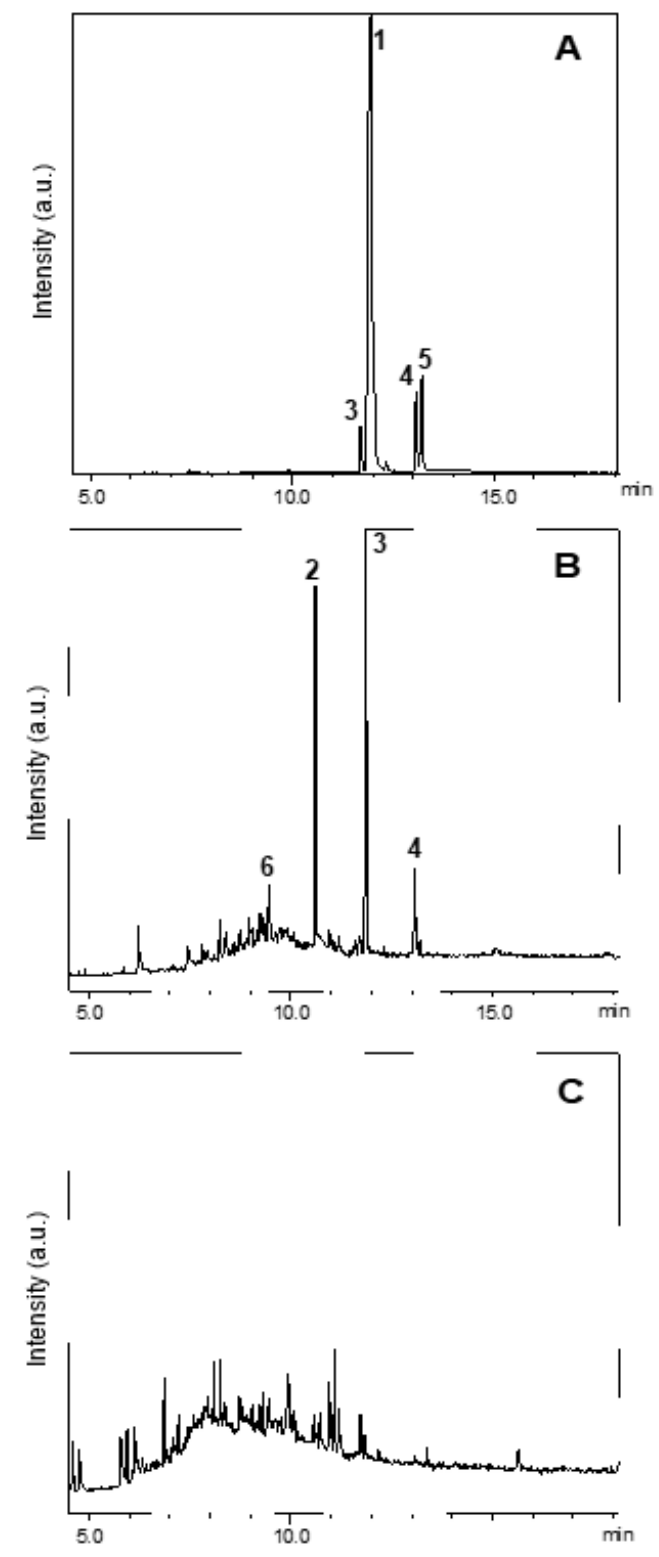
Figure 15. GC–MS chromatogram of ( A ) fipronil; ( B ) aqueous solution of fipronil after 120 min under exposure to UV light in the sealed chamber, in the absence of a catalyst; and ( C ) aqueous solution of fipronil after 8 h under exposure to UV light in the sealed chamber, in the presence of Zn-AlPO 4 ( C ). Fipronil ( 1 ), desthioderivative ( 2 ), fipronil–sulfide ( 3 ), 4-thiol–fipronil ( 4 ), fipronil–sulfone ( 5 ), and 2-[2-(2,6-dichloro-4-(trifluoromethyl) phenyl) diazenyl] acetonitrile ( 6 ).